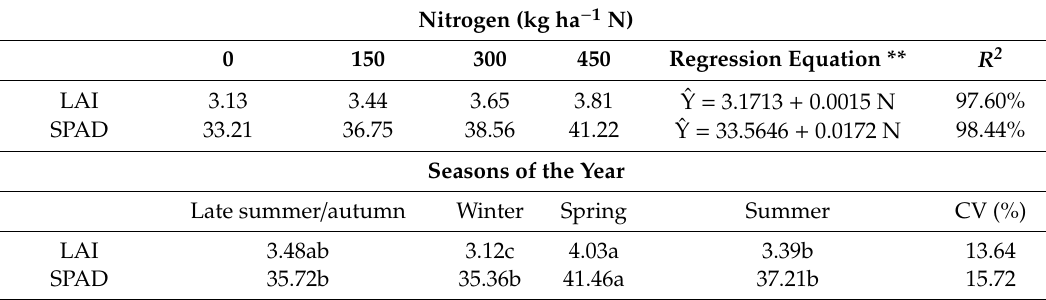
Table 7. Averages for leaf area index (LAI) and Soil Plant Analysis Diagnostic index (SPAD index) in the pre-grazing forage of Brachiaria brizantha cv. Piatã under rotational stocking and nitrogen fertilization throughout seasons of the year.